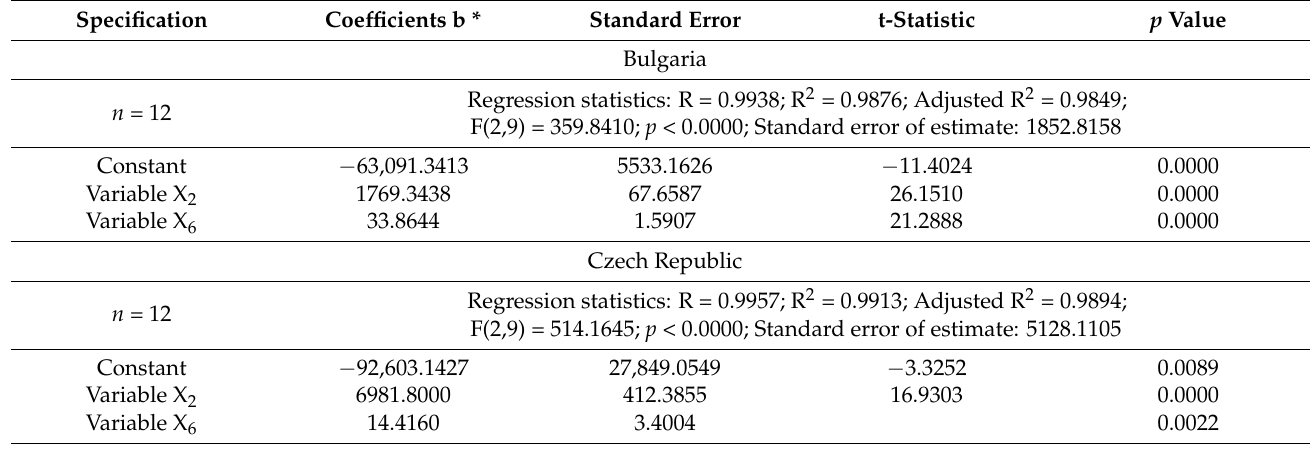
Table 3. Results of regression analysis for CEE countries calculated for the period 2008–2019 (at 0.05 significance level).